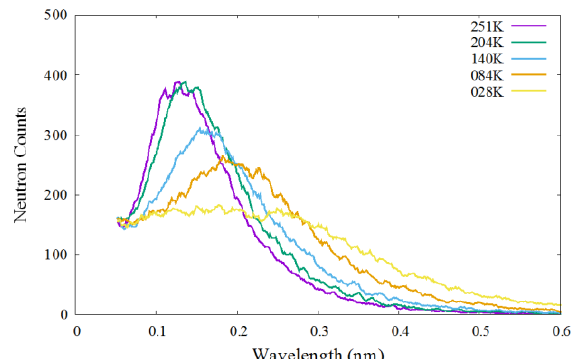
Fig. 2. TOF neutron spectra for various temperature of the mesitylene moderator.